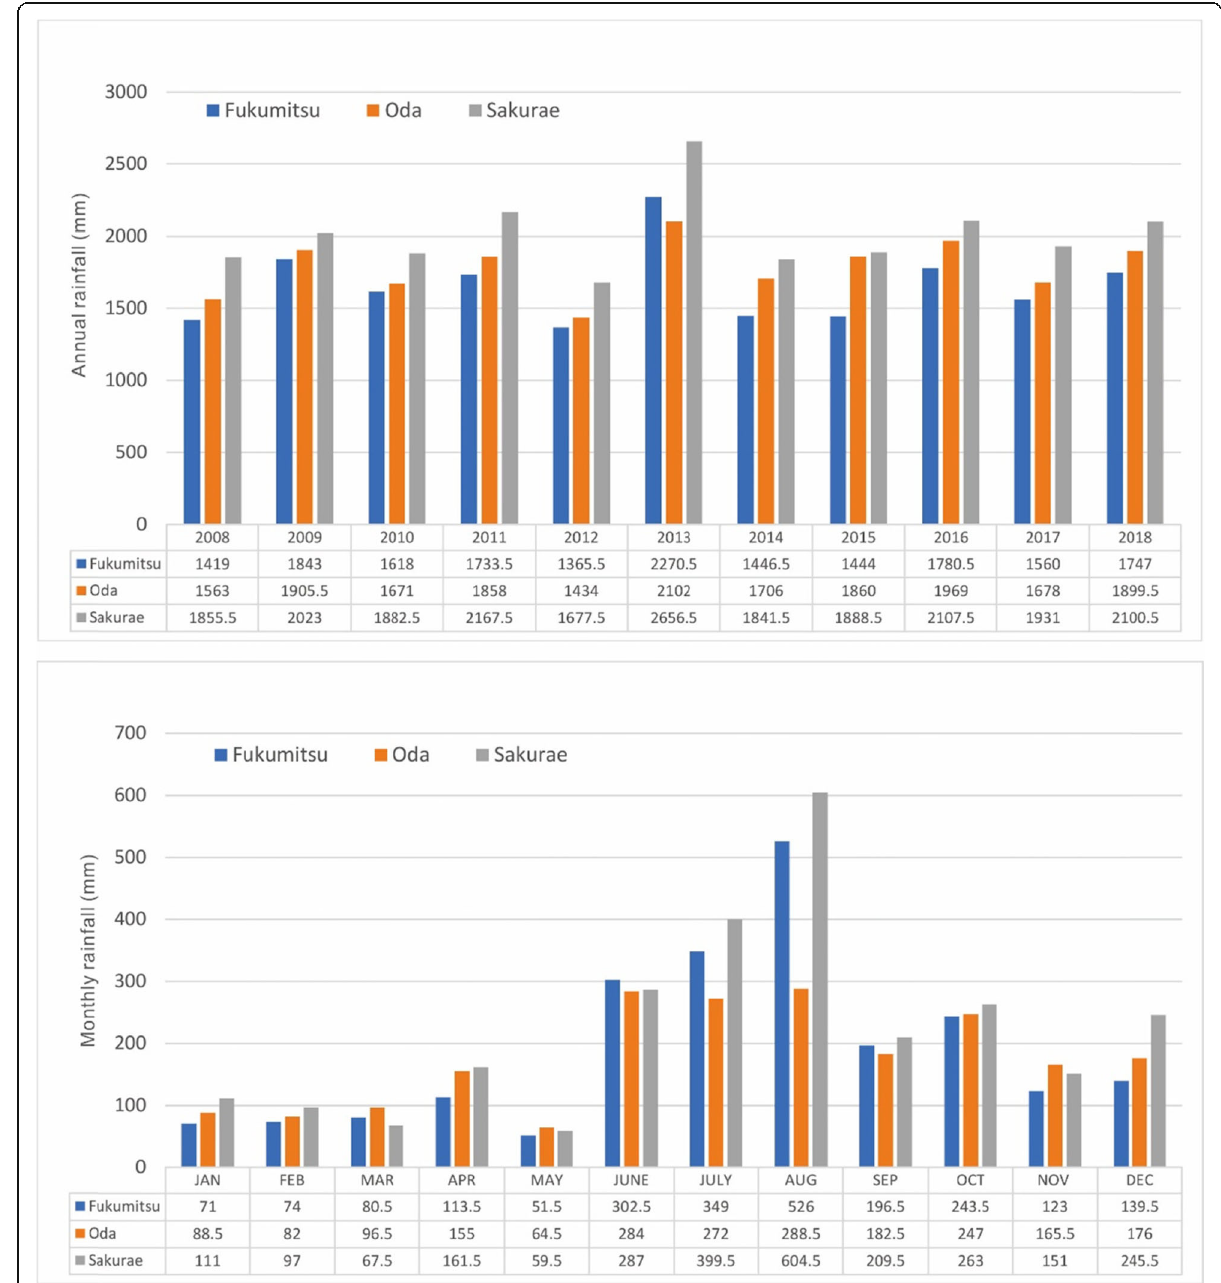
Fig. 2 Annual rainfall from 2008 to 2018, and monthly rainfall of 2013 in the study